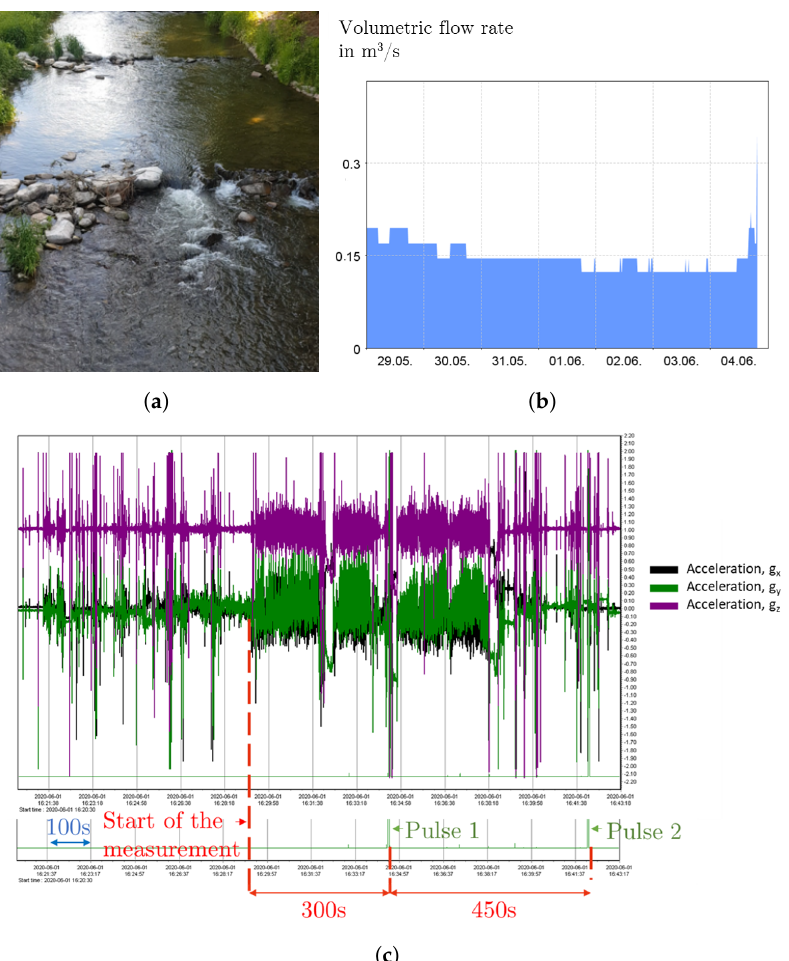
Figure 14. ( a ) Field measurement location, ( b ) volumetric flow rate of the river during the measure- ment period according to data provided by the Saxon State Office for Environment, Agriculture and Geology, ( c ) acceleration values and output voltage from the MSR 160 data